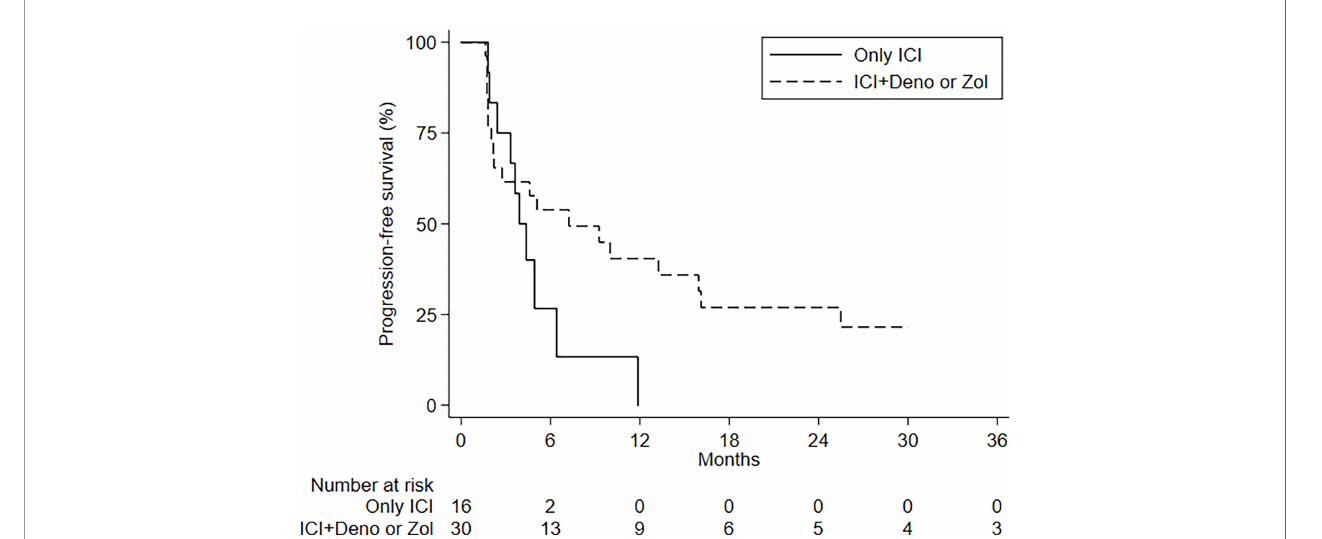
FIGURE 3 | PFS by